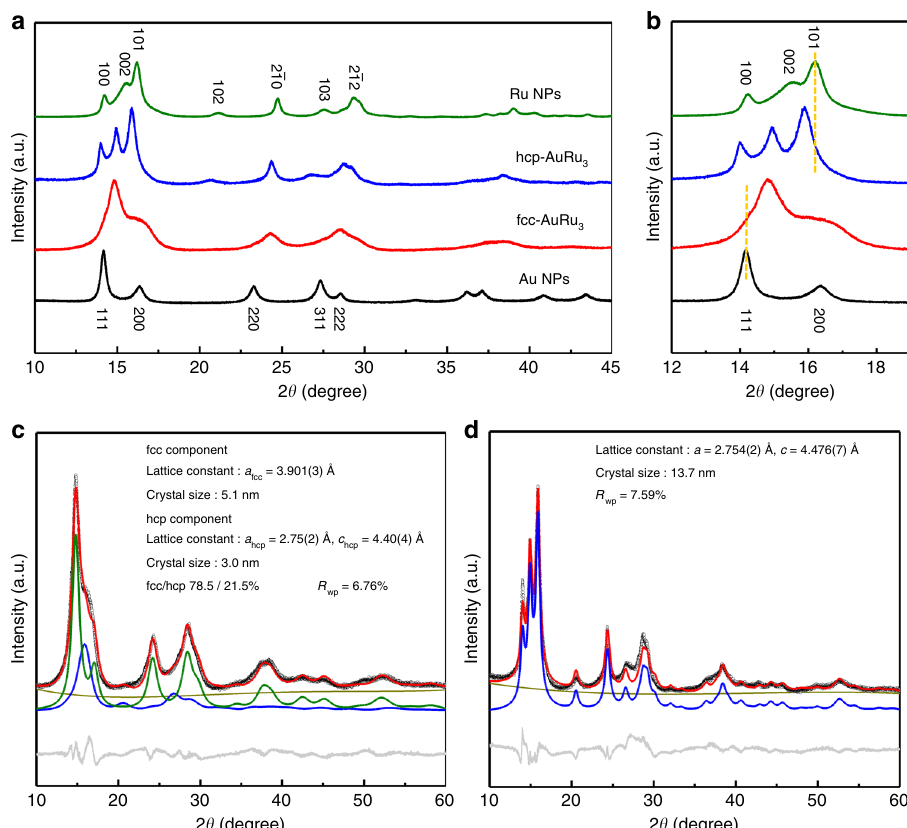
Fig. 2 Synchrotron XRD analysis of AuRu 3 NPs. a Synchrotron XRD patterns of Au, fcc-AuRu 3 , hcp-AuRu 3 and Ru NPs at 303 K, 2 θ = 10° to 45°. b The close-up view of 2 θ = 12° to 19°. The radiation wavelength was 0.57865(1) Å. c , d The Rietveld re fi nement for the fcc-AuRu 3 and hcp-AuRu 3 NPs. The diffraction patterns are shown as black circles. The calculated patterns are shown as red lines. The difference pro fi le, the background pro fi le and the fi tting curves of the fcc and hcp components are shown as grey, dark yellow, green and blue lines,